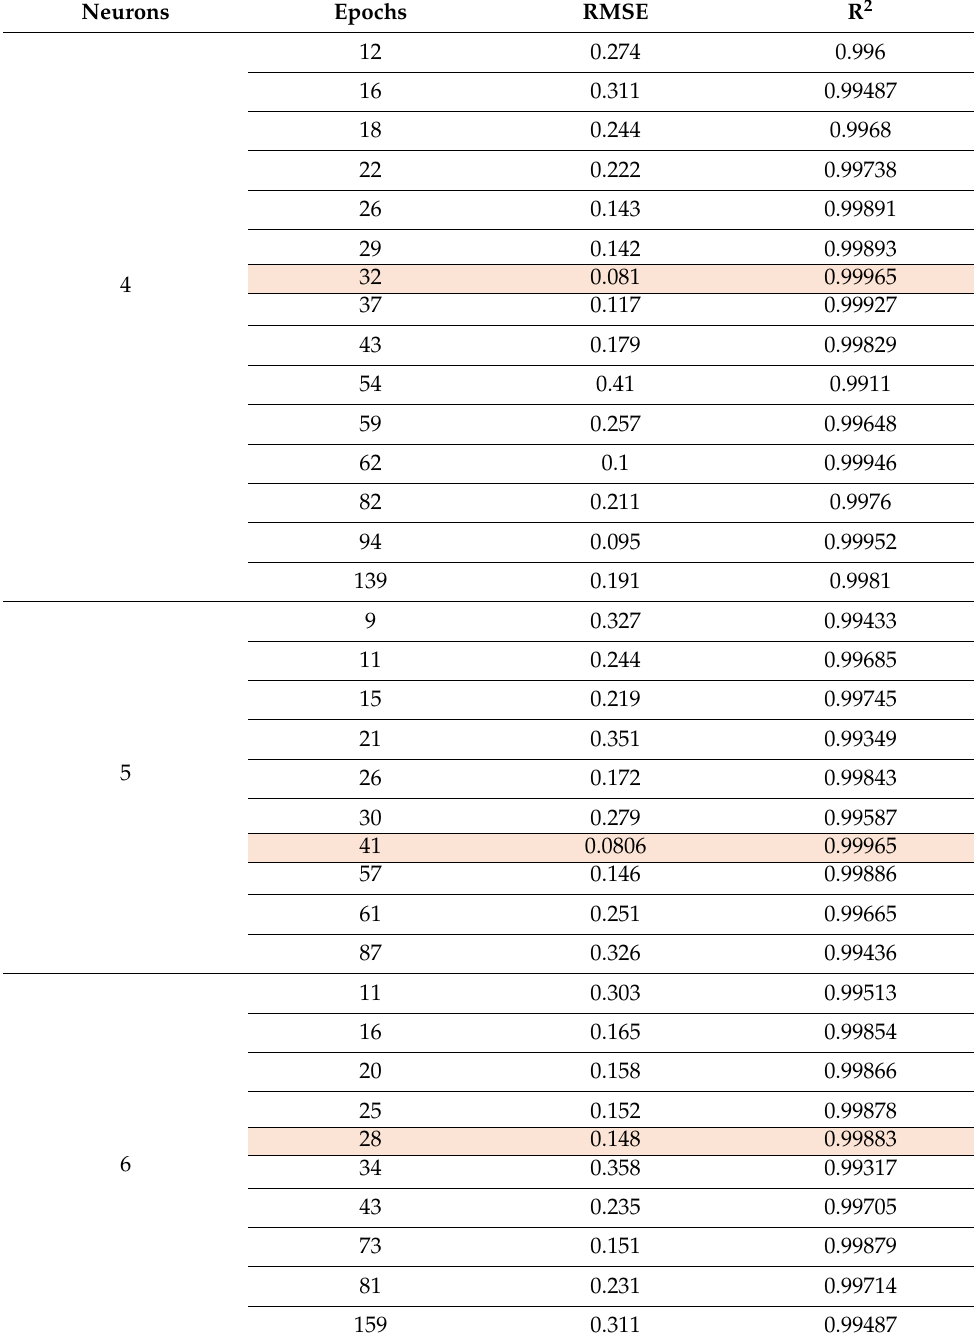
Table A1. Prediction performance of ANN based on the number of epochs and